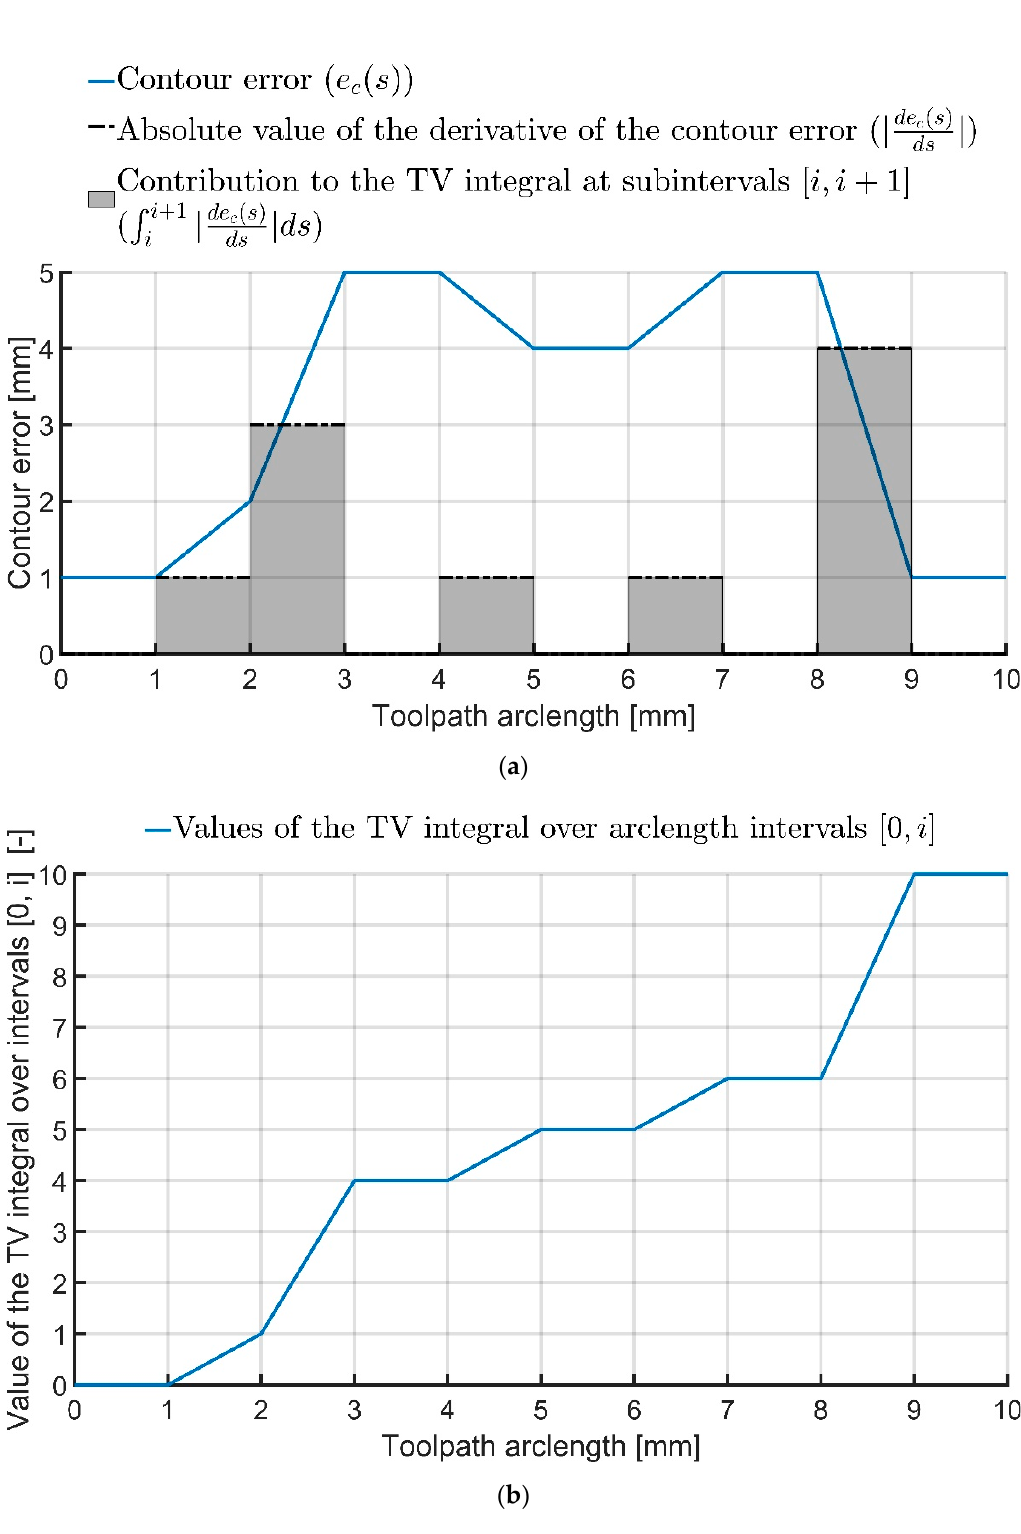
Figure 6. Illustrative example of the calculation and behavior of the TV parameter. ( a ) An illustrative example of a contour error evolution along a measured segment of the toolpath (blue path). Dashed black lines denote derivative of the contour error. The gray areas denote contributions of the subdivision intervals of the form [i, i + 1] to the total value of the TV integral. ( b ) This graph demonstrates how the value of the TV integral increases as the contributions are summed over increasing portions of the total arclength. Note that the normalization of the TV coefficient by the total length of 10 mm was omitted to make the example more intuitive. It should be noted here that the use of the TV coefficient is justified when comparing cases in which the shape of the contour error function is similar up to scaling (such as in